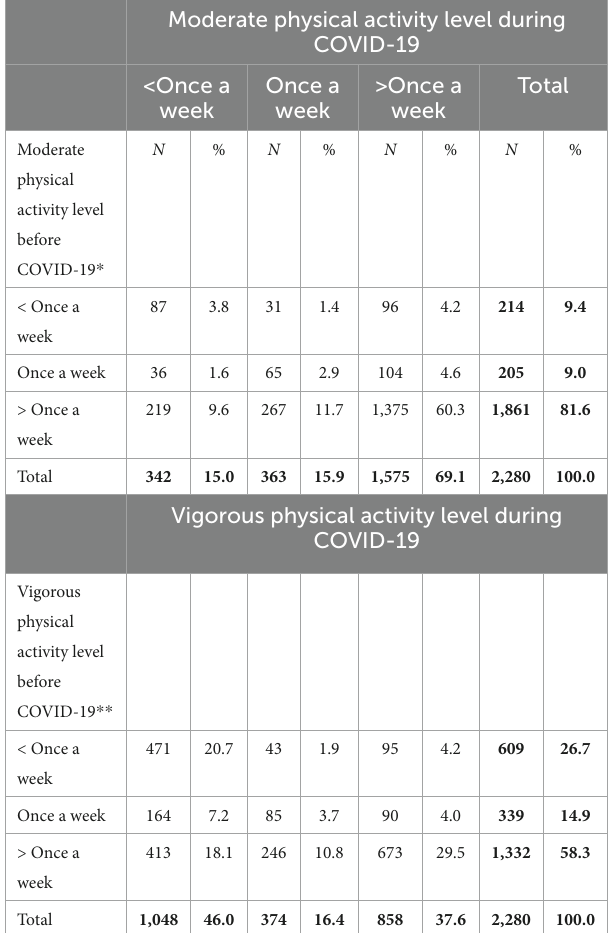
TABLE 1 Description of the study population in the Danish part of the “COVID-19 International Student Well-being Study” carried out in May– June 2020 among 2,280 university students at the University of Southern Denmark and University of Copenhagen.